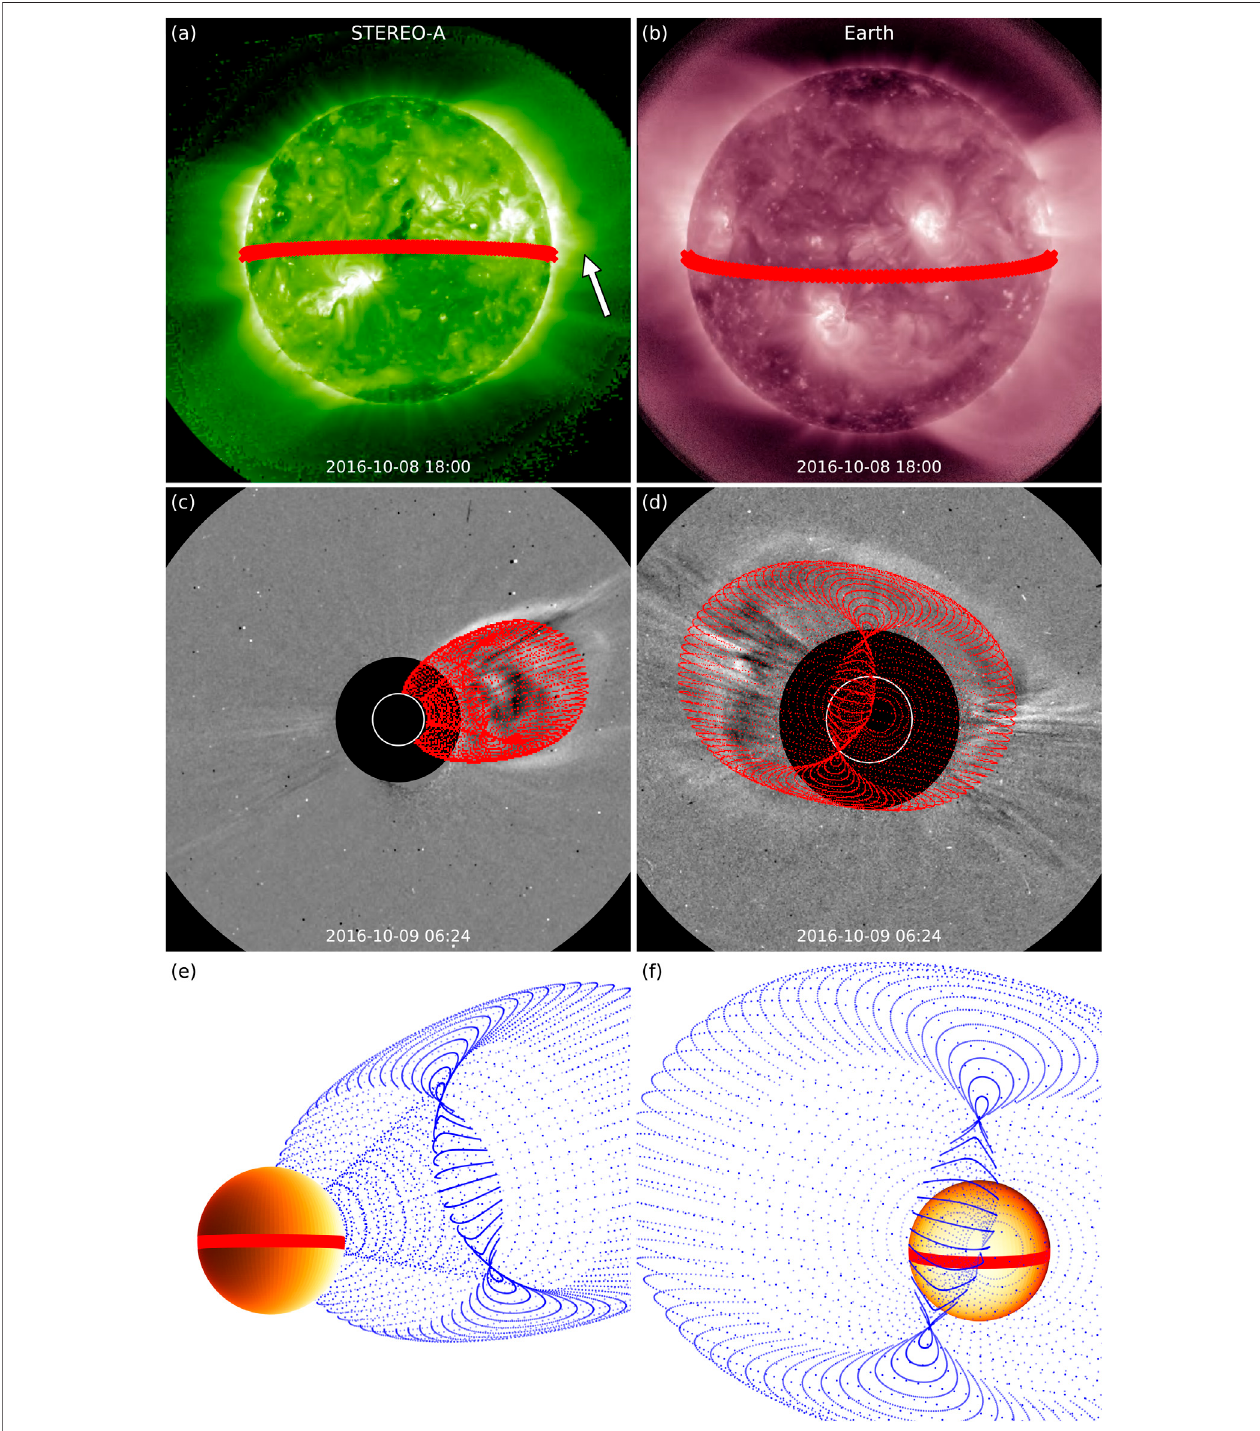
FIGURE8| Geometric techniques applied tothe2016October8CME(Event4). (A – B) Latitude (thickred line)oftheCMEcore (indicated withanarrow)projected onto the solar disc as seen by STEREO-A and SDO. (C – D) GCS reconstruction applied to the white-light structure seen in STEREO-A and SOHO. (E – F) The GCS- reconstructed CME displayed together with the “ source latitude ” from (A) and (B) in a 3D representation and shown from the two viewpoints of STEREO-A and Earth.